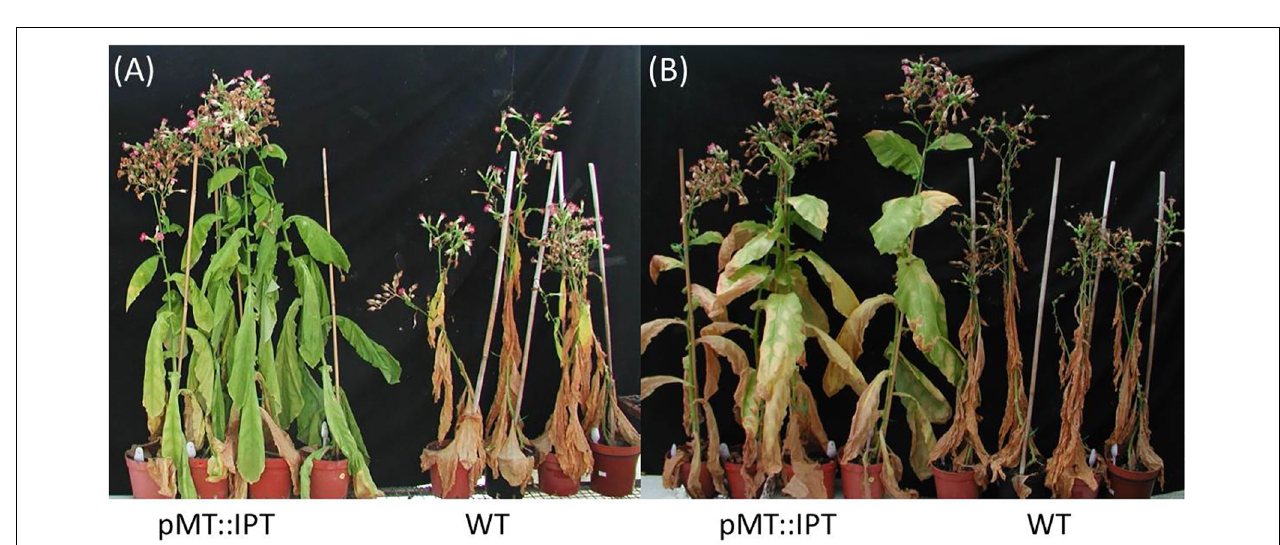
FIGURE 2 | Responses of transgenic pMT:IPT compared to WT plants during drought-stress treatment. Three-month old tobacco plants were subjected to a drought stress of 2 or 3 weeks. (A) Withholding watering for 2 weeks. (B) Three weeks of withholding watering followed by 1 week of re-watering. Pictures represent one of three independent experiments showing similar